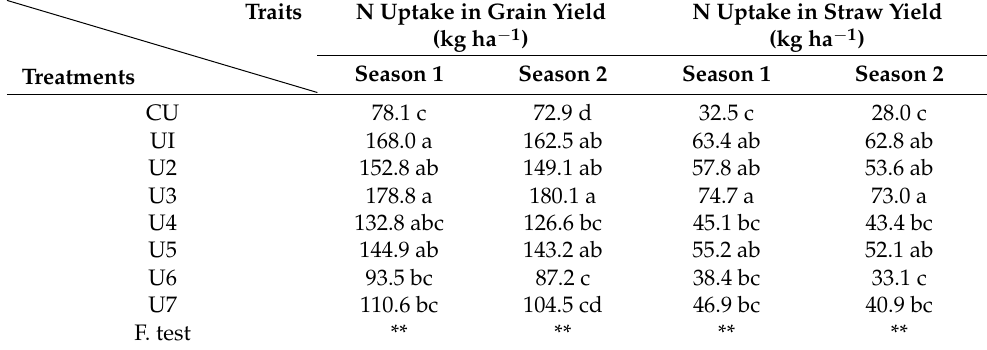
Table 9. Effects of different rates of classical urea fertilizer, urea chitosan nanohybrid, and their combinations as an exogenous application on N uptake in both grain and straw of rice during the 2020 and 2021 seasons. N Uptake in Straw Yield Traits N Uptake in Grain Yield (kg ha − 1 ) (kg ha − 1 Treatments